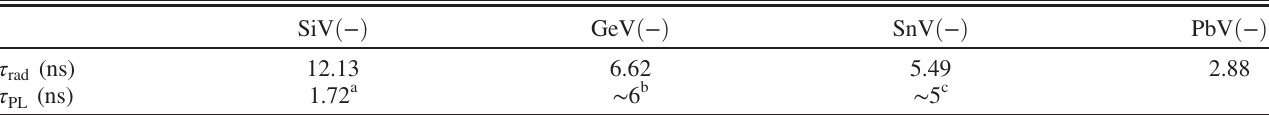
) for X V ð − Þ color centers at PL . We note that τ involves both rad PL